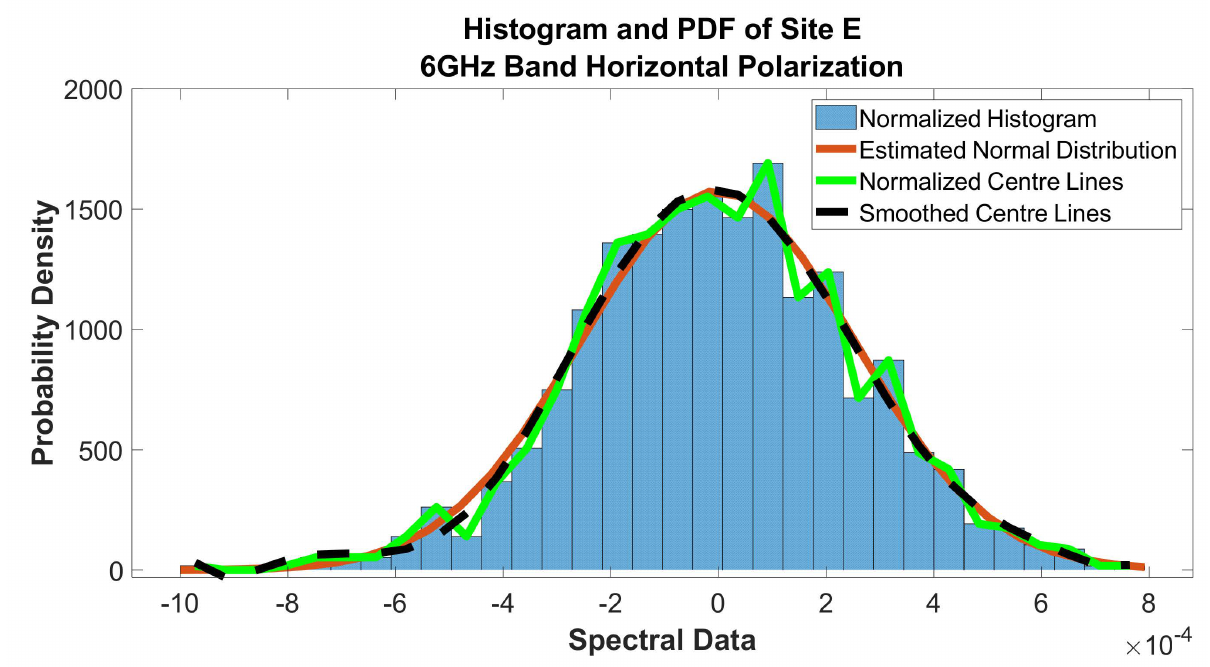
Figure 46. The 8 GHz vertical polarization scan for all sites after denoising and applying the algorithm to all sites, including those without the potential to cause interference.